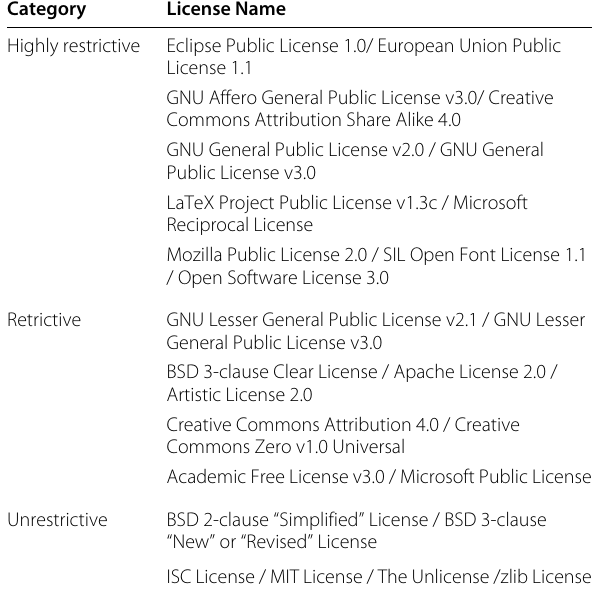
Table 3 Frequently used open-source license classification